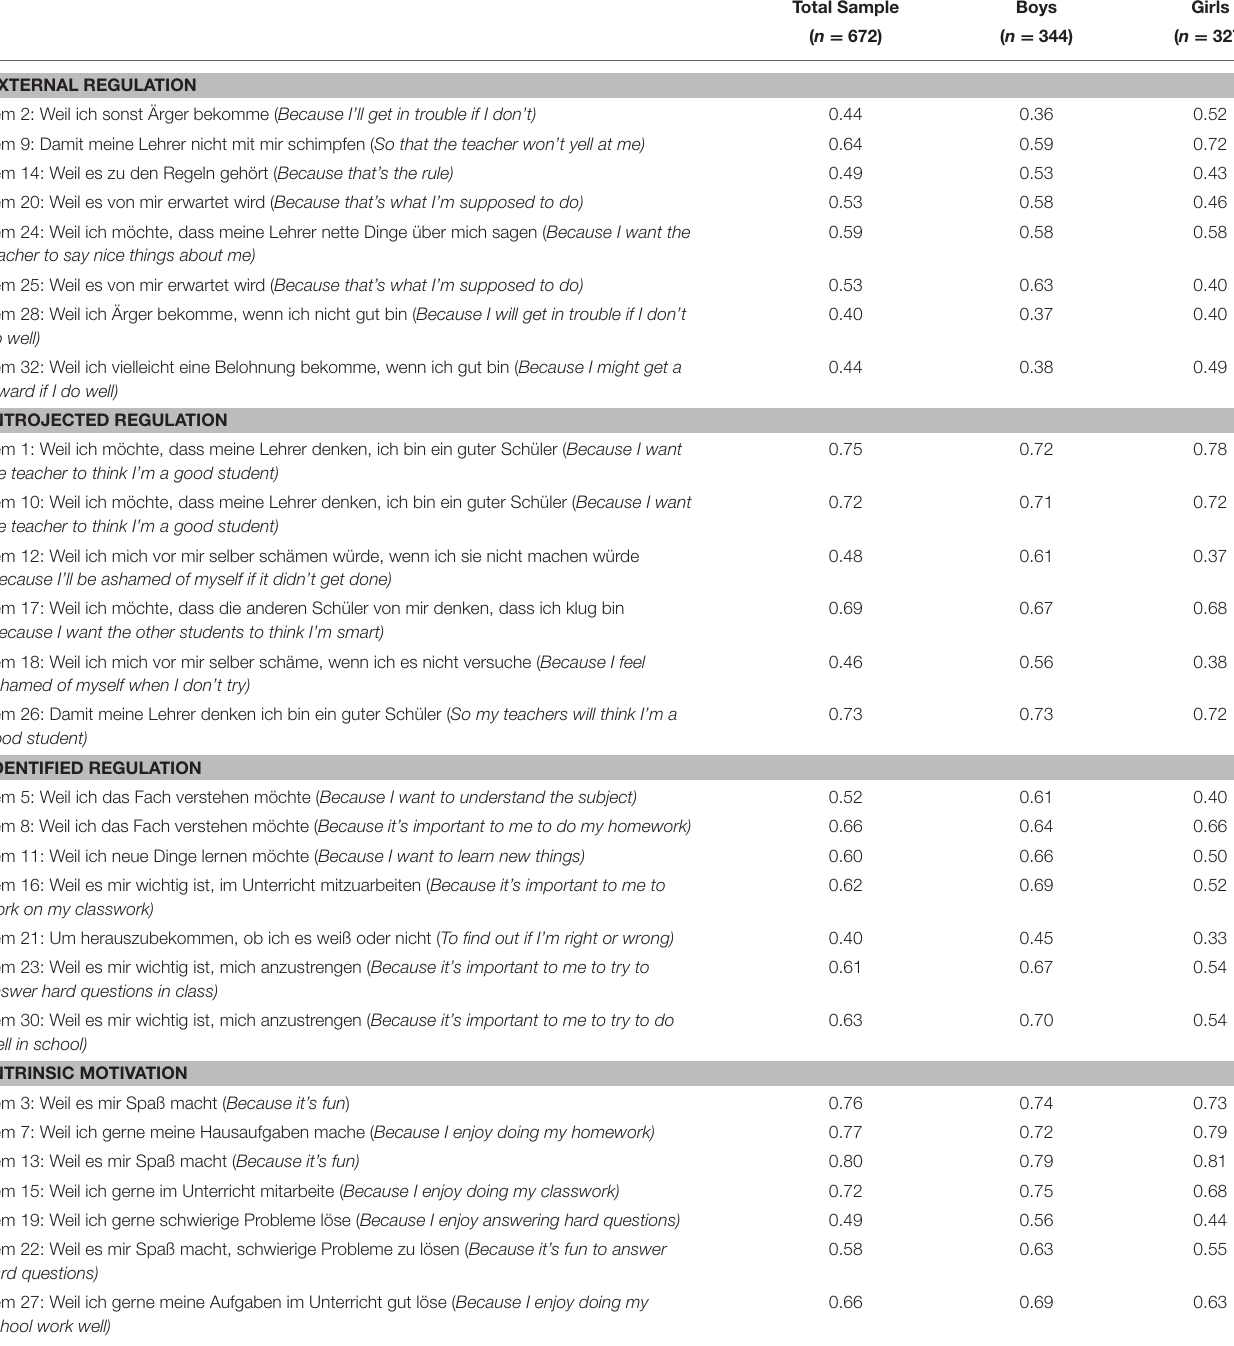
TABLE 4 | Factorial loadings of the SRQ-A by subscale and gender.